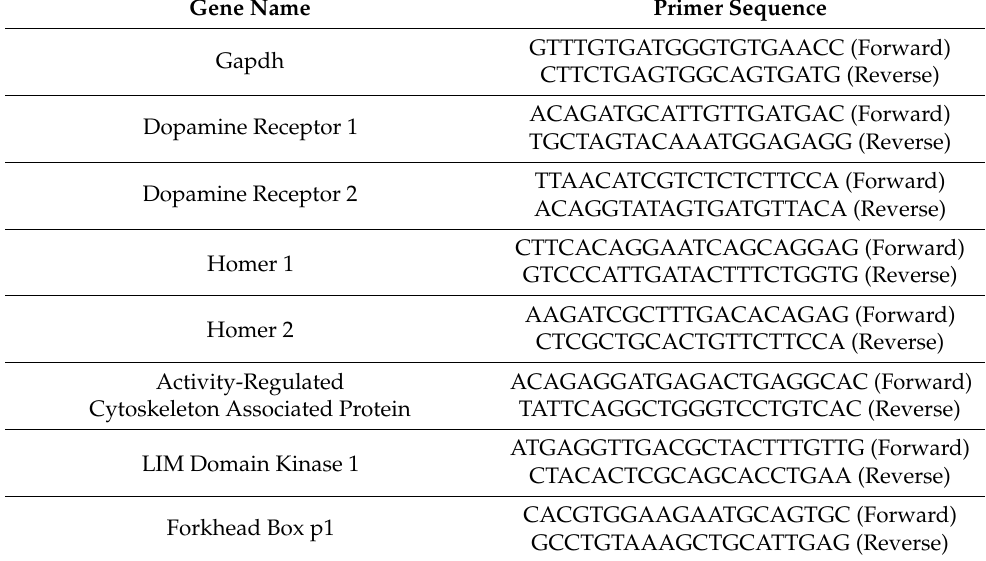
Table 1. Primers employed in qRT-PCR